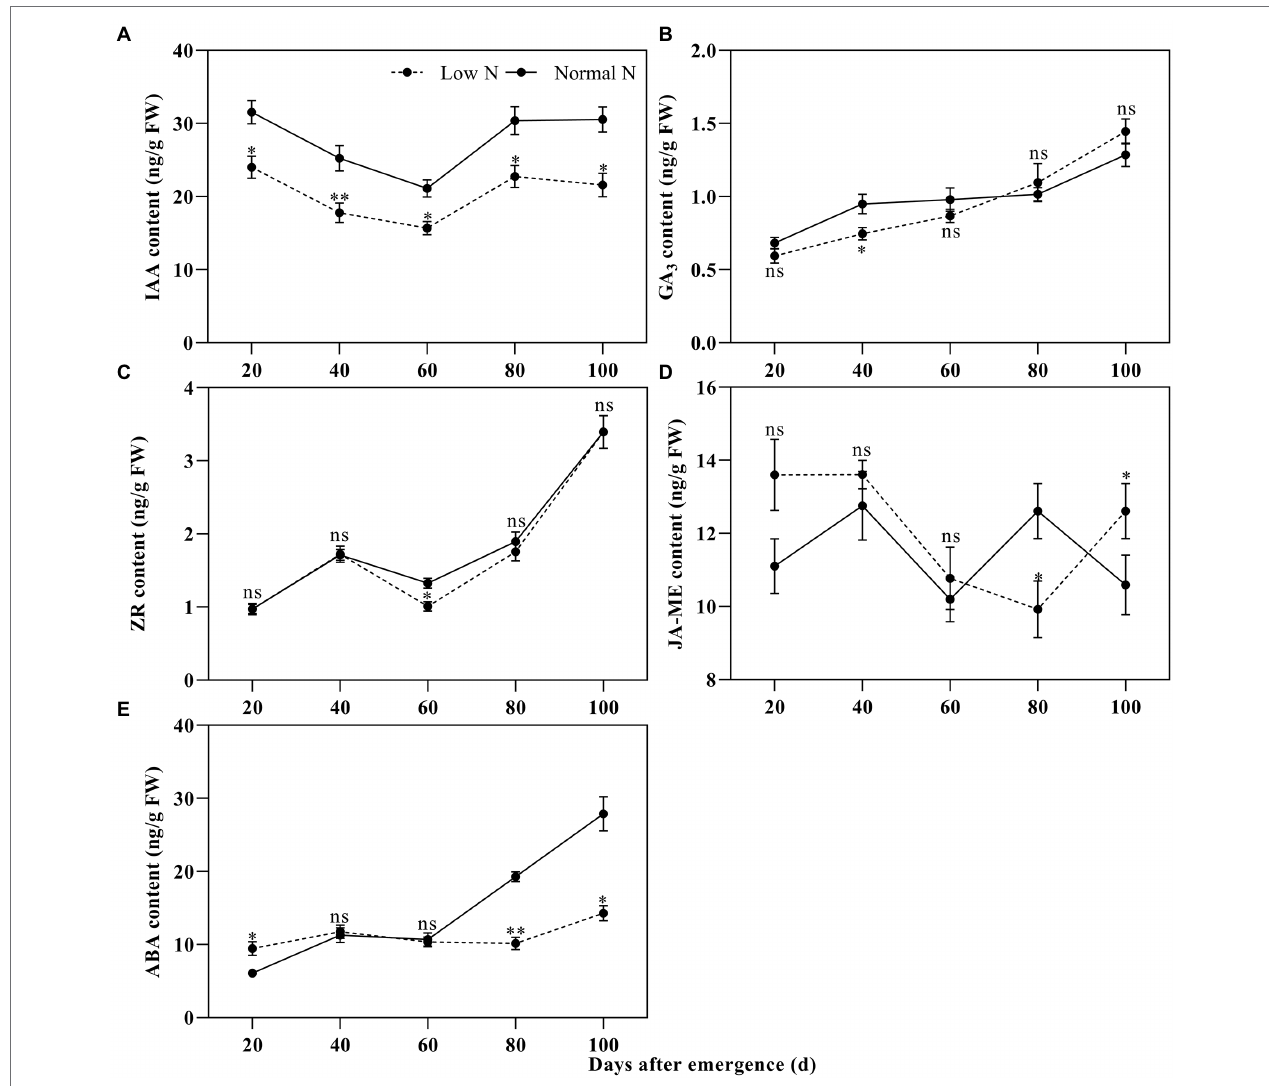
FIGURE 3 | Dynamic changes in the indole-3-acetic acid (IAA; A ), gibberellin A3 (GA 3 ; B ), zeatin riboside (ZR; C ), methyl jasmonate (JA-ME; D ), and abscisic acid (ABA; E ) content of cotton roots under different nitrogen treatments. Depicted are the means of three replicates ± SE. ns, not significant ( p > 0.05), * p < 0.05, ** p <